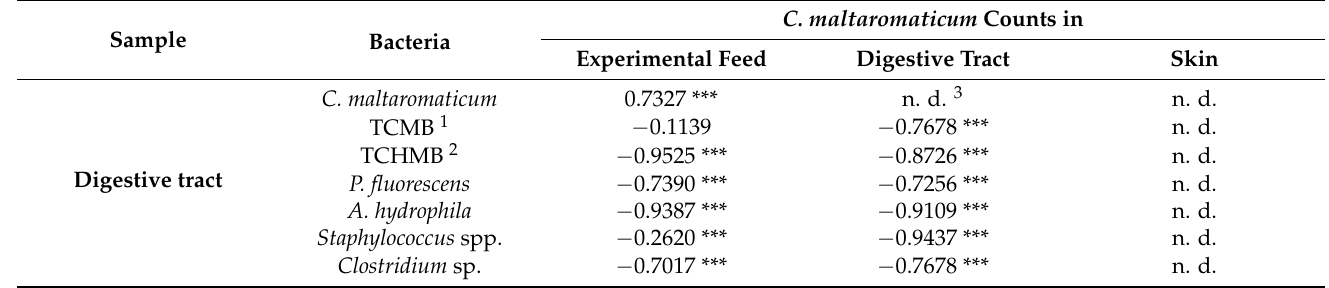
Table 4. Correlation coefficients denoting the strength of the relationships between Carnobacterium maltaromaticum counts in the experimental feed, digestive tract, and skin samples ( n =